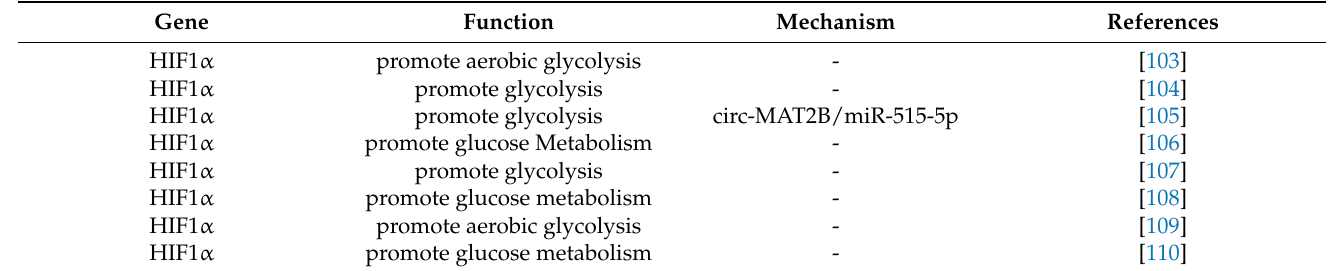
Table 7. HIF regulates gastric cancer progression by gastric cancer cell metabolism.